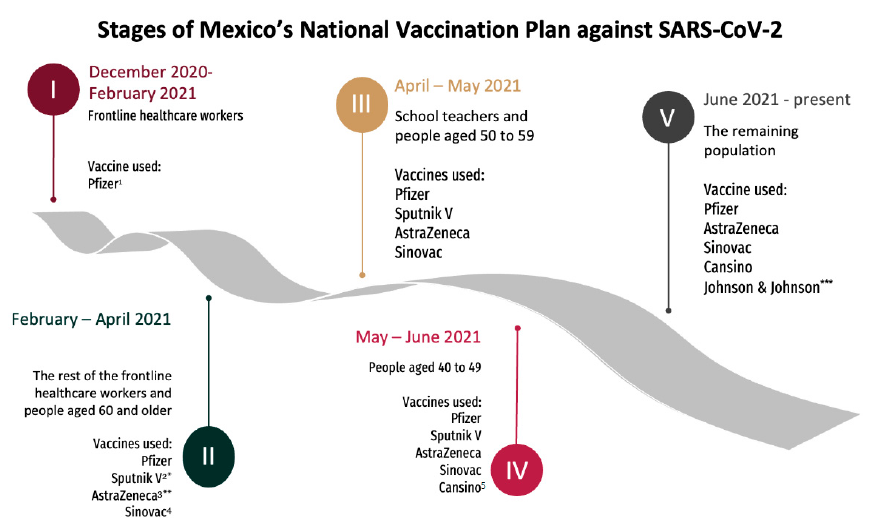
Figure 1. Vaccination strategy in Mexico. 1 BNT162b2 (Pfizer-BioNTech), 2 Gam-COVID-Vac (Gamaleya’s Sputnik V), 3 ChAdOx1 (AstraZeneca), 4 CoronaVac (Sinovac Life Sciences), and 5 Ad5nCoV (CanSino-BIO). Adapted from Política Nacional de Vacunación Contra el Virus SARS-CoV-2, Para la Prevención de la COVID-19 en México 2021 [11]. * The Sputnik V vaccine was not administered in the state of Baja-California. ** Includes a group of AstraZeneca vaccines manufactured at India’s Serum Institute (COVISHIELD) administered in Stage II in Baja-California. *** Johnson & Johnson vaccines were administered along the border in Stage V thanks to a donation from the Government of the United States of America Government as part of binational efforts to reopen the U.S.A.–Mexico border [16].